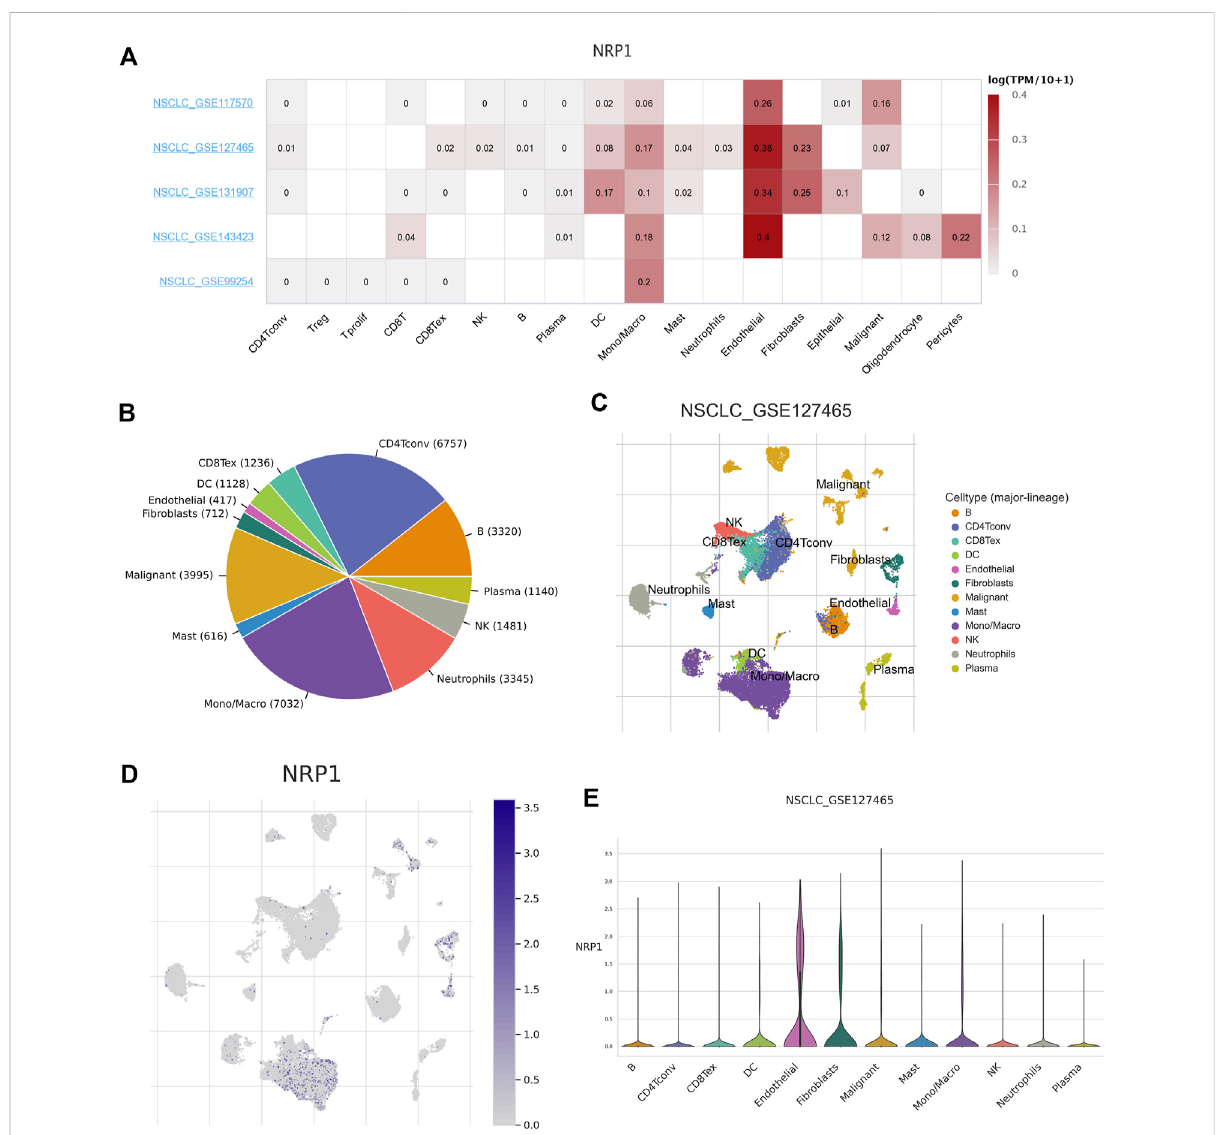
Correlation between NRP1 expression and TME in NSCLC (A) The heatmap showing the correlation between NRP1 expressionlevel and TME in NSCLC tissues. (B) Pie chart showing the number of each cell type in the NSCLC_GSE127465 dataset (C) The distribution of each cell type in